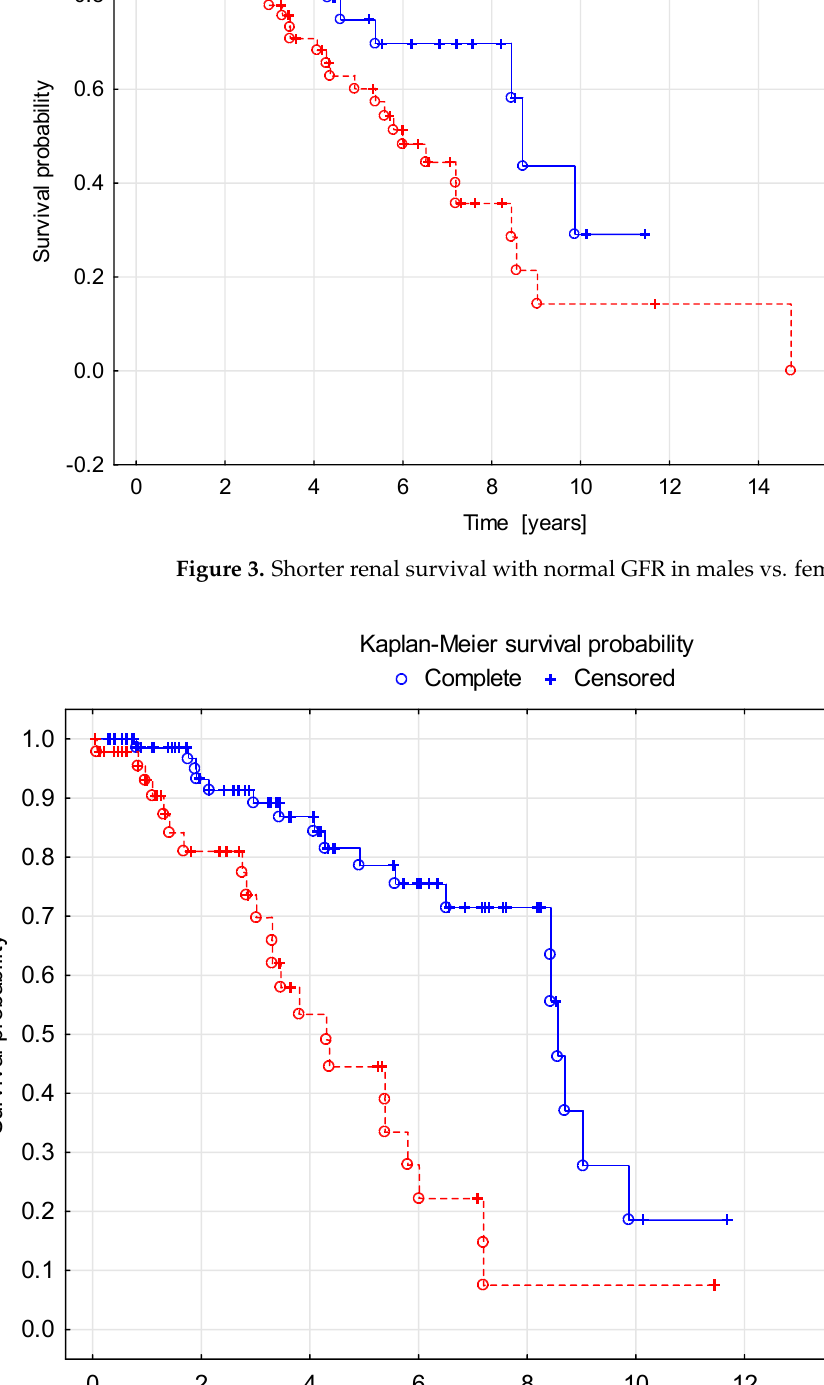
Figure 4. Shorter renal survival with normal GFR in patients with reduced GFR (<90 mL/min) at the time of the diagnosis. Survival curve analysis using the Cox proportional hazard model showed no differ- ence in renal survival with normal GFR between groups with normal and reduced serum C3 levels at baseline.